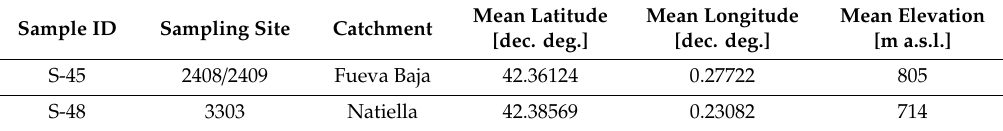
Figure 4. Outlet of the Natiella catchment and 10 Be bedload sampling site 2. Inset: OSL sampling of buried cobbles in a low-lying fluvial-cut terrace at site 3. Table 1. Bedload sampling sites (Figure 4) and reference locations used for 10 Be catchment wide erosion rates that were calculated with CRONUS-Earth online calculator 2.3. Scaling scheme applied: Stone [51], modified from Lal [43].